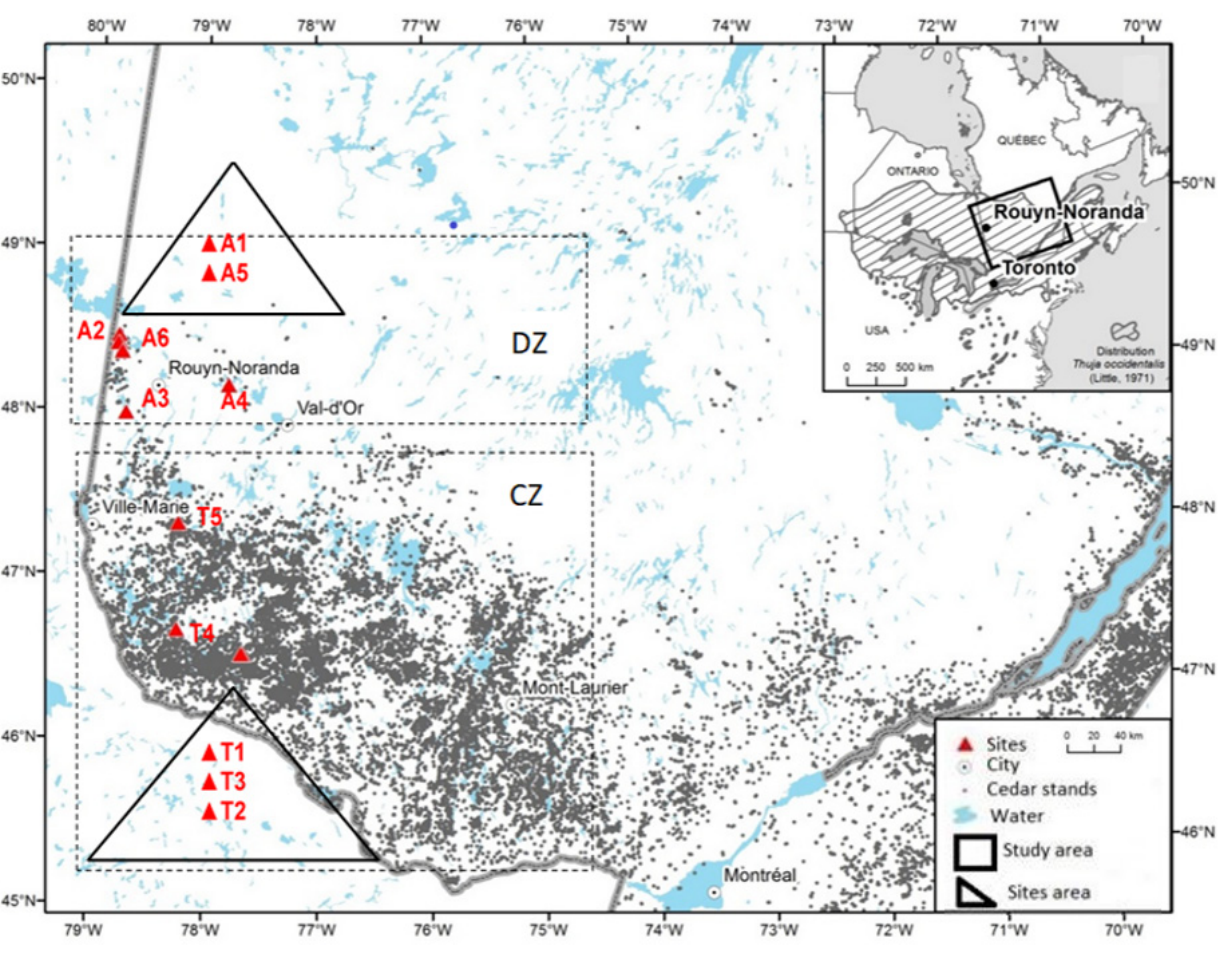
to cover the full distribution of the species in this region and a wide range of ecological conditions (Figure 1): six stands in the Abitibi region (A1, A2, A3, A4, A5, and A6) and five stands in the T é miscamingue region (T1, T2, T3, T4, and T5). The study area is divided into two bioclimatic zones based on the abundance of EWC (Figure 1). The continuous zone (CZ) falls into the balsam fir and yellow birch ( Betula alleghaniensis Britton) bioclimatic domain and represents an area where cedar is common [31,32]. The discontinuous zone (DZ) is in the balsam fir and white birch ( Betula papyrifera Marsh.) bioclimatic domain. It marks the northern edge of the continuous distribution, where cedar becomes less common in the forest matrix. The site occupation rates by EWC along the gradient were estimated to